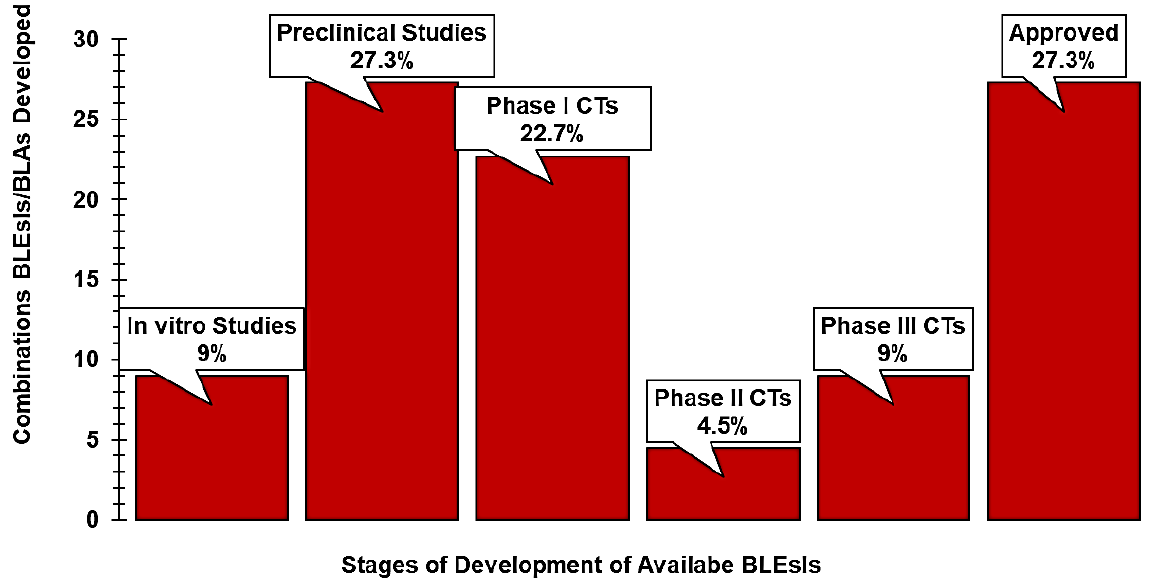
Figure 7. Percentages of BLEsIs developed so far at the various stage of progress. CTs = clinical trials.